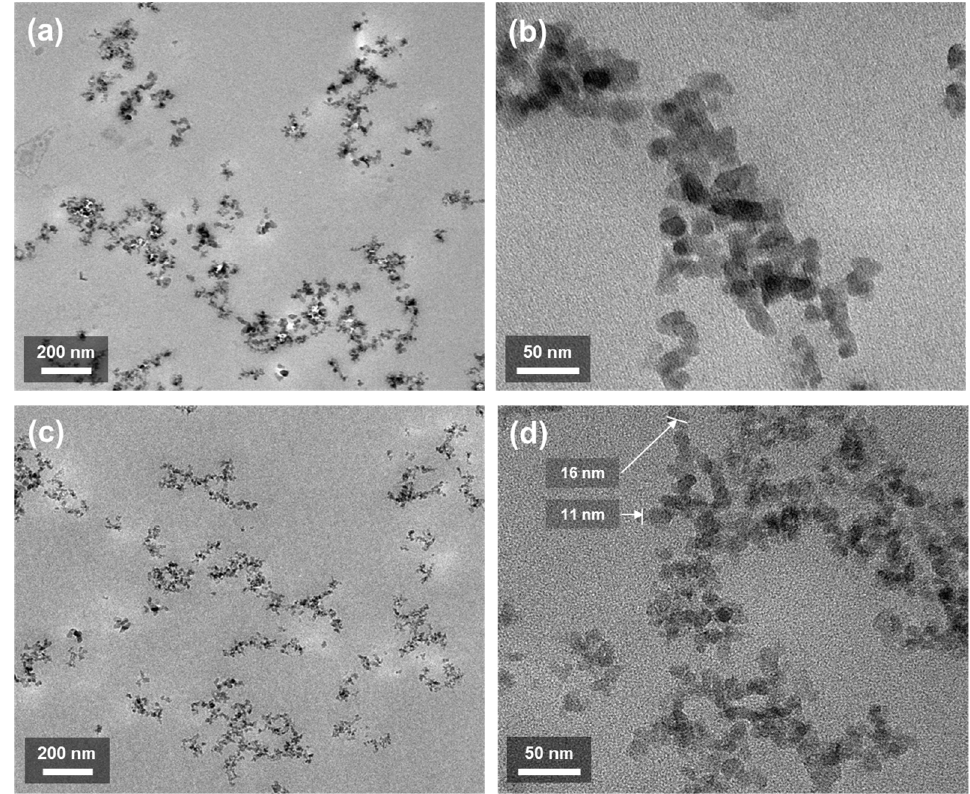
Figure 3. TEM images of the epoxy/fumed silica composite with 3 wt.% ( a , b ) fumed silica and ( c , d ) PDMS-treated silica.